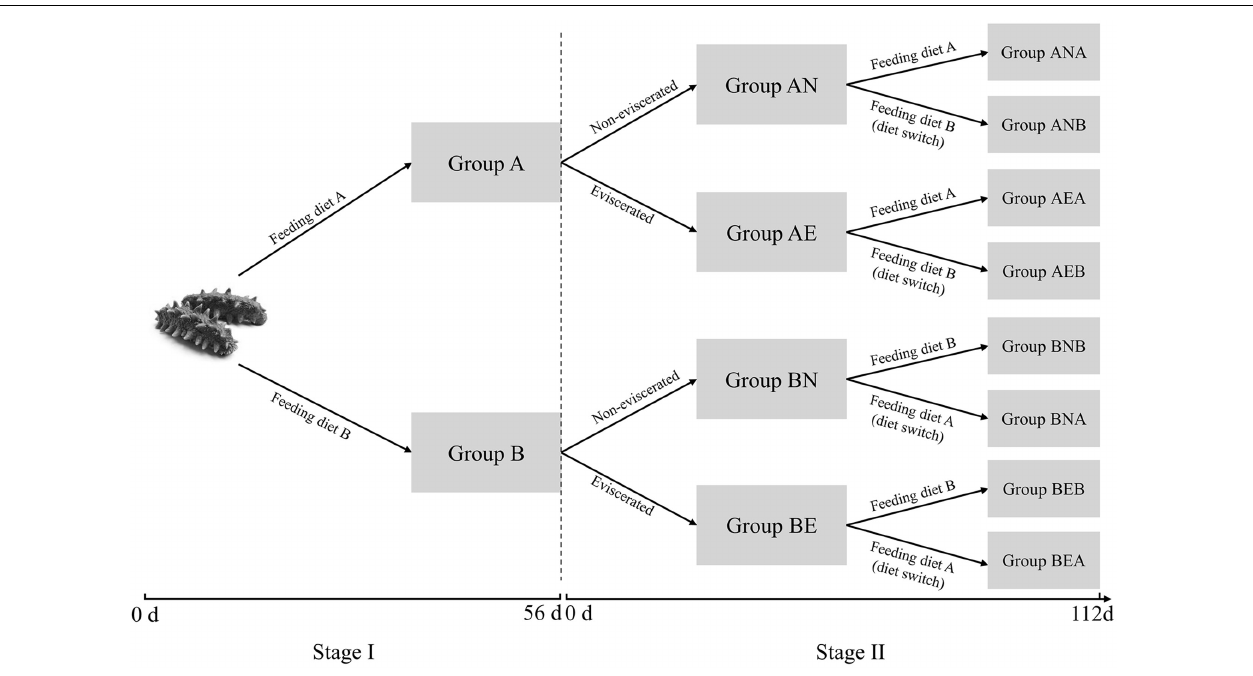
FIGURE 1 | Schematic presentation of diet-switch experiment in A. japonicus . The whole experiment was carried out for 168 days and classified into two stages. In stage I, A. japonicus were randomly assigned to group A and group B, which were fed diet A and diet B for 56 days, respectively. In stage II, each group was subjected to evisceration or not (eviscerated and non-eviscerated), and switched to different diets from diet A to B or vice versa for 112